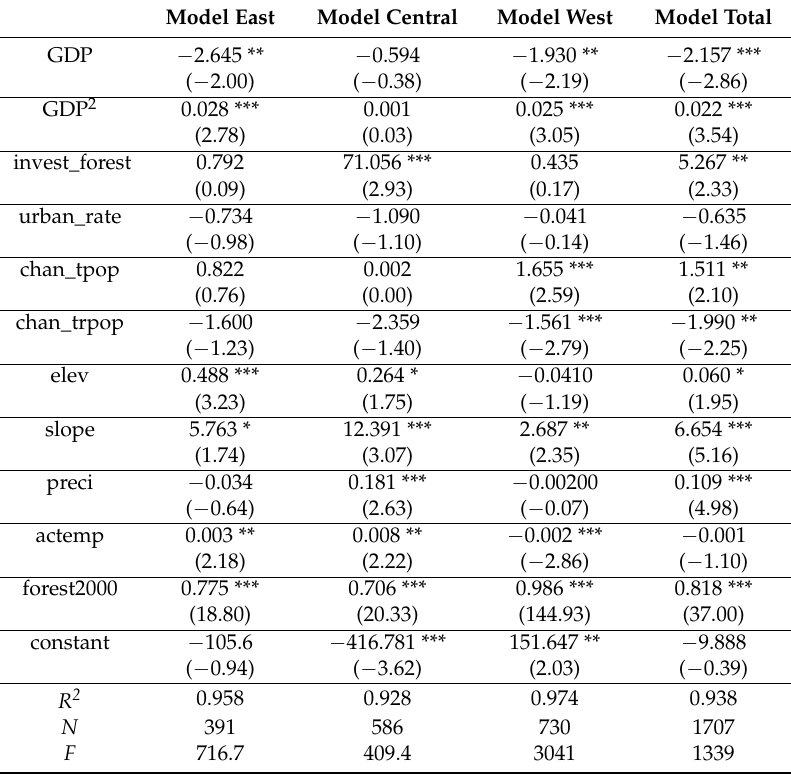
Table 4. Description of variables and modeling